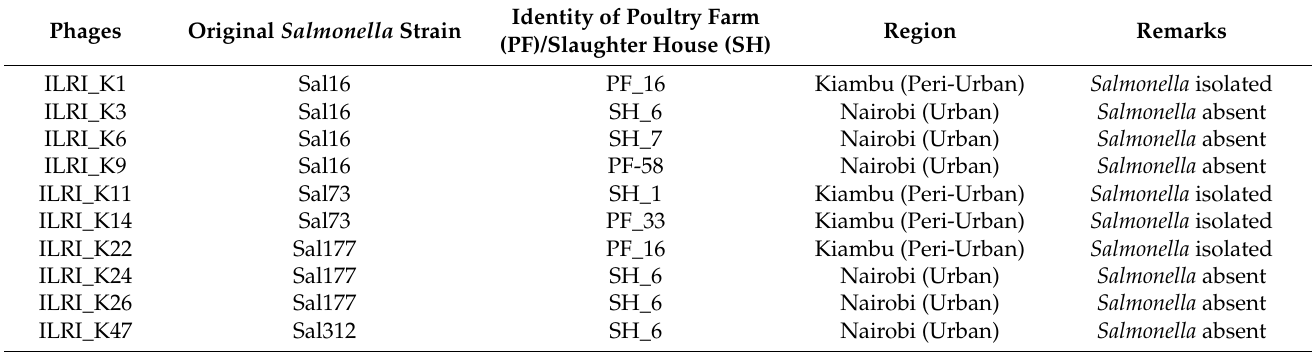
Table 2. Phages and S . Enteritidis host strains used in the phage isolation